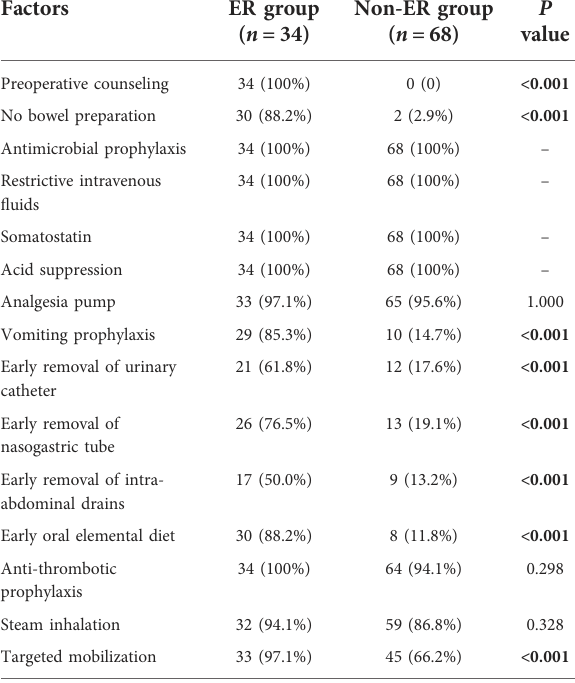
TABLE 5 Compliance with factors of ERAS protocols. 15 compliance factors of ERAS protocols were used to compare between two groups including preoperative counseling, no bowel preparation, antimicrobial prophylaxis, restrictive intravenous fl uids, somatostatin, acid suppression, analgesia pump, vomiting prophylaxis, early removal of urinary catheter, early removal of nasogastric tube, early removal of intra-abdominal drains, early oral elemental diet, anti- thrombotic prophylaxis, steam inhalation, targeted